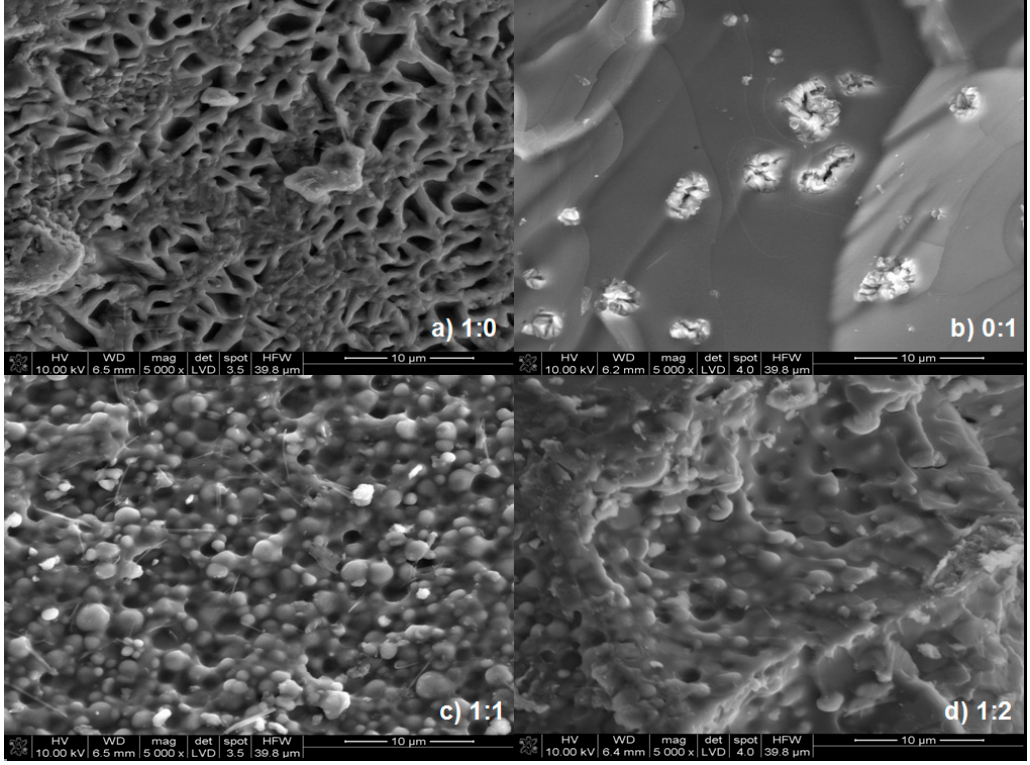
Figure 14. SEM microphotographs: ( a ) R-150 sodium water glass (1:0), ( b ) cross-linked sodium polyacrylate (0:1), ( c ) hydrogel sample of the 1:1 mass ratio of the sodium water glass to the sodium polyacrylate, ( d ) hydrogel sample of the 1:2 mass ratio of the sodium water glass to the sodium polyacrylate.